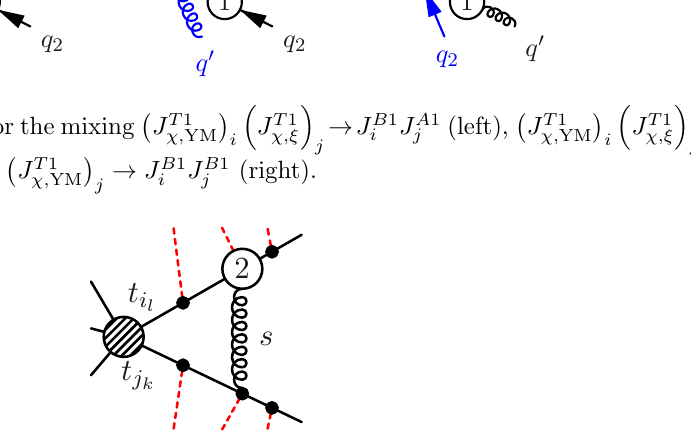
J B 1 J A 1 (left), i j